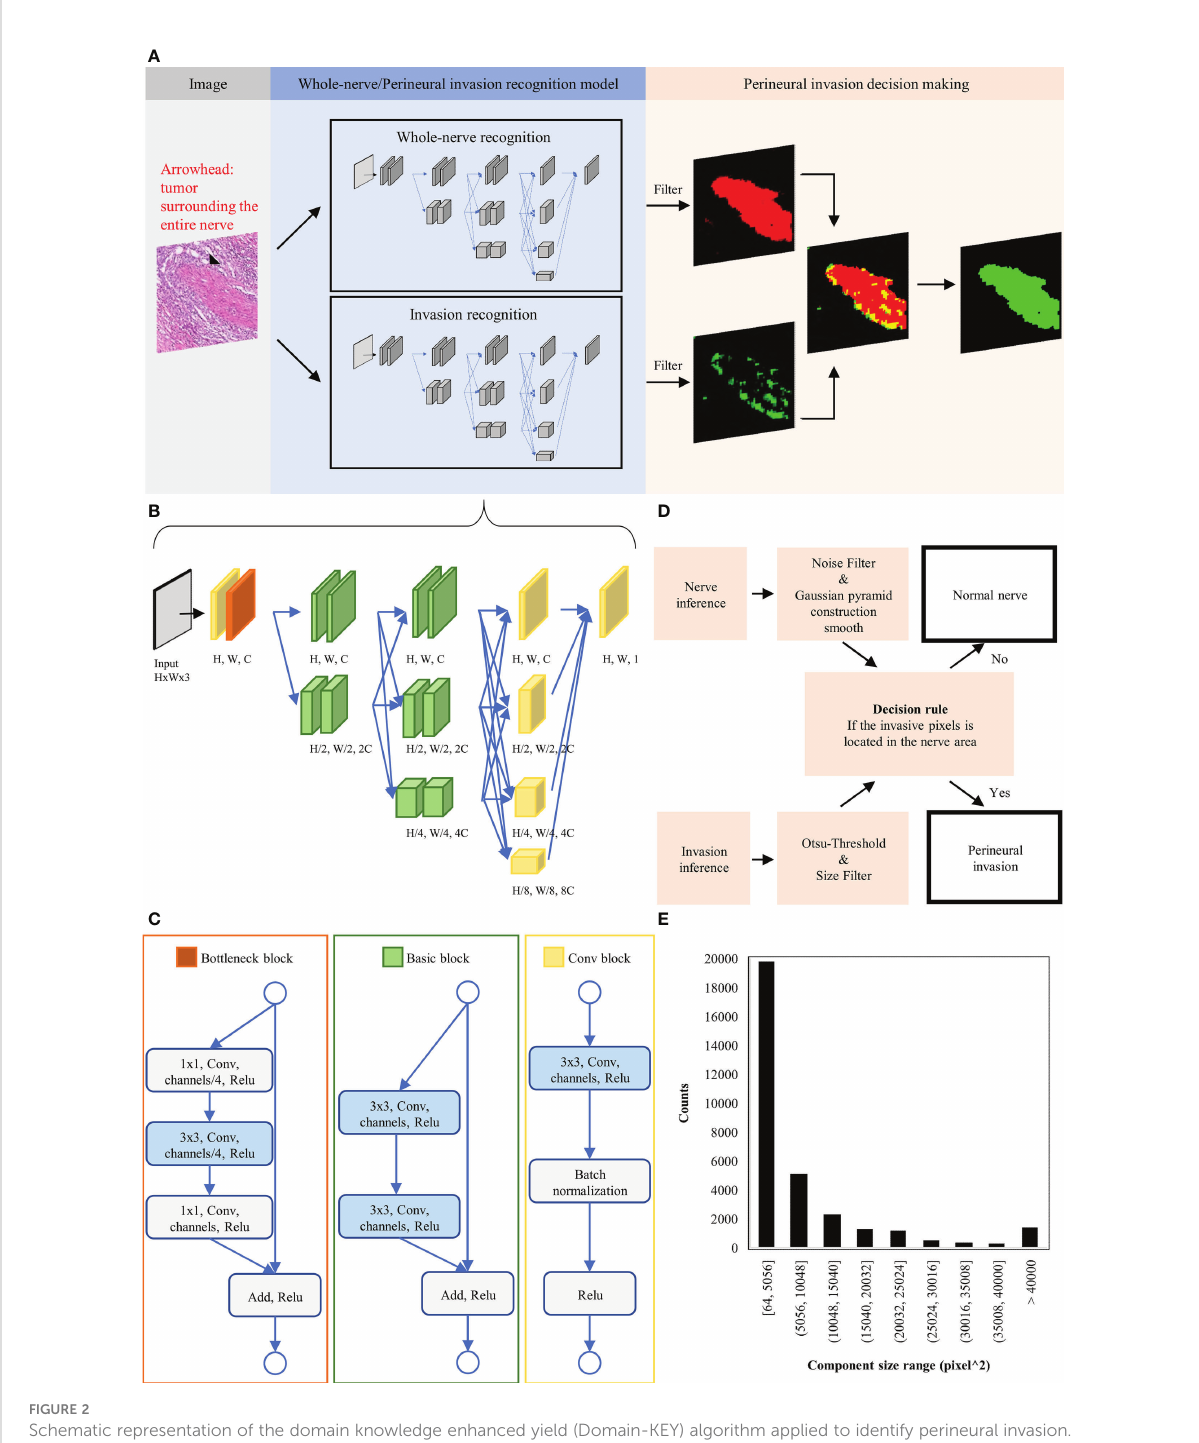
FIGURE 2 Schematic representation of the domain knowledge enhanced yield (Domain-KEY) algorithm applied to identify perineural invasion. (A) Work fl ow for algorithm development. (B) Architecture of the deep learning image segmentation model used to identify normal nerve structures and perineural invasion. (C) Detailed description of the function block architecture. (D) Creation of a rule fl ow for identifying perineural invasion. Inferred results from the identi fi cation of normal nerve structures and perineural invasion underwent post-processing and irregular components were fi ltered out. Each nerve structure was subsequently inspected for the presence or absence of perineural invasion. (E) Distribution of the invasive component outside the nerve structure. These fi ndings were considered as noisy signals and used to choose fi lters of appropriate